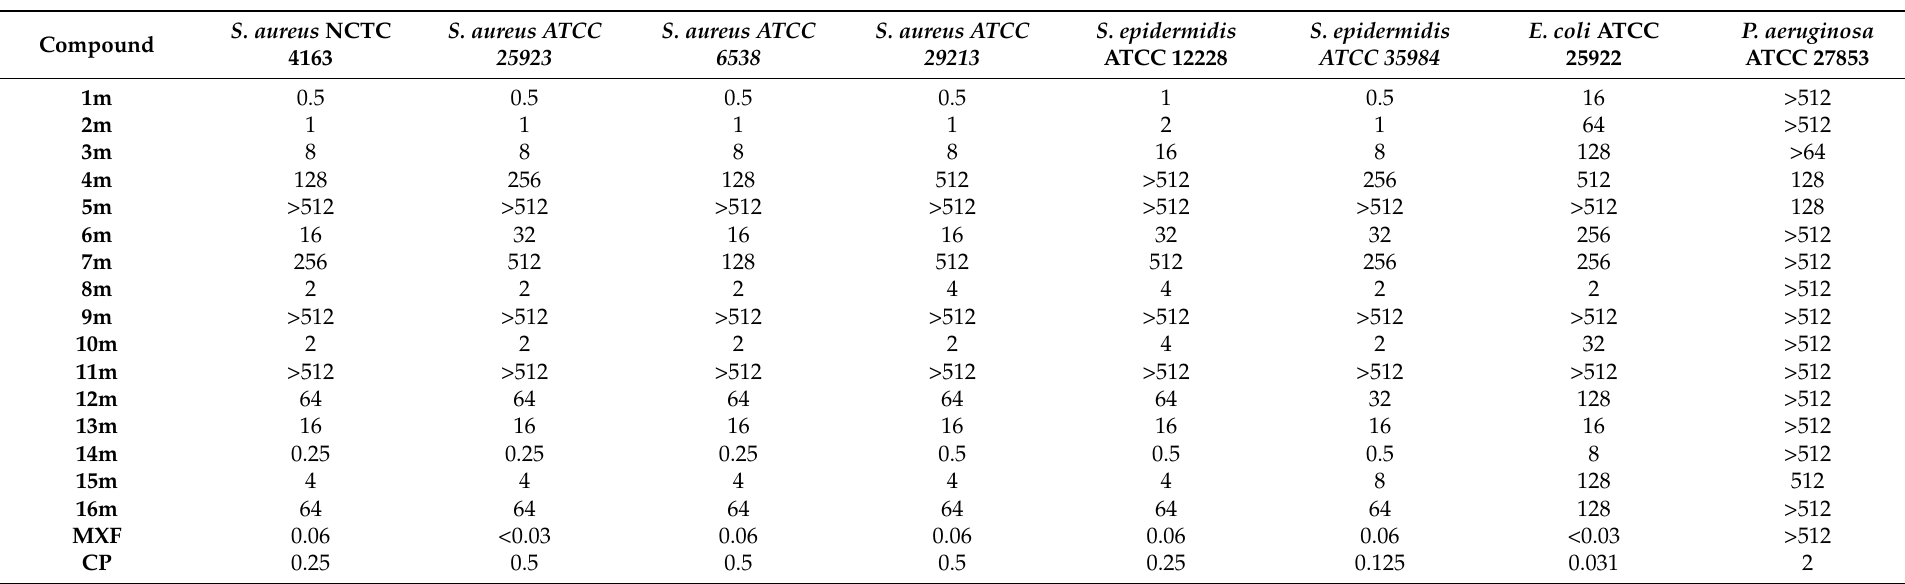
Table 2. Activities of MXF conjugates ( 1m – 16m ) on standard bacterial strains after 18 h of treatment-minimal inhibitory concentrations (MIC, µ g/mL).